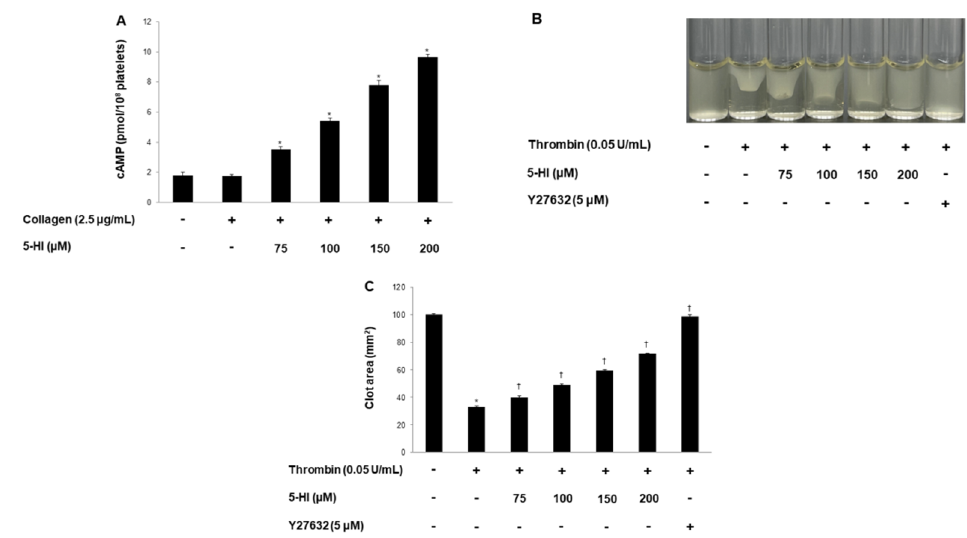
Figure 5. Effect of 5-HI on cAMP concentration and fibrin clot retraction. ( A ) 5-HI’s effect on collagen- induced cAMP production. ( B ) Photographs of fibrin clot. ( C ) 5-HI’s effect on thrombin-retracted fibrin clot (%). All experiments were performed as describe in “Materials and Methods” section. The data are expressed as the mean ± standard deviation (n = 4). * p < 0.05 versus the unstimulated human PRP, † p < 0.05 versus the thrombin-stimulated human